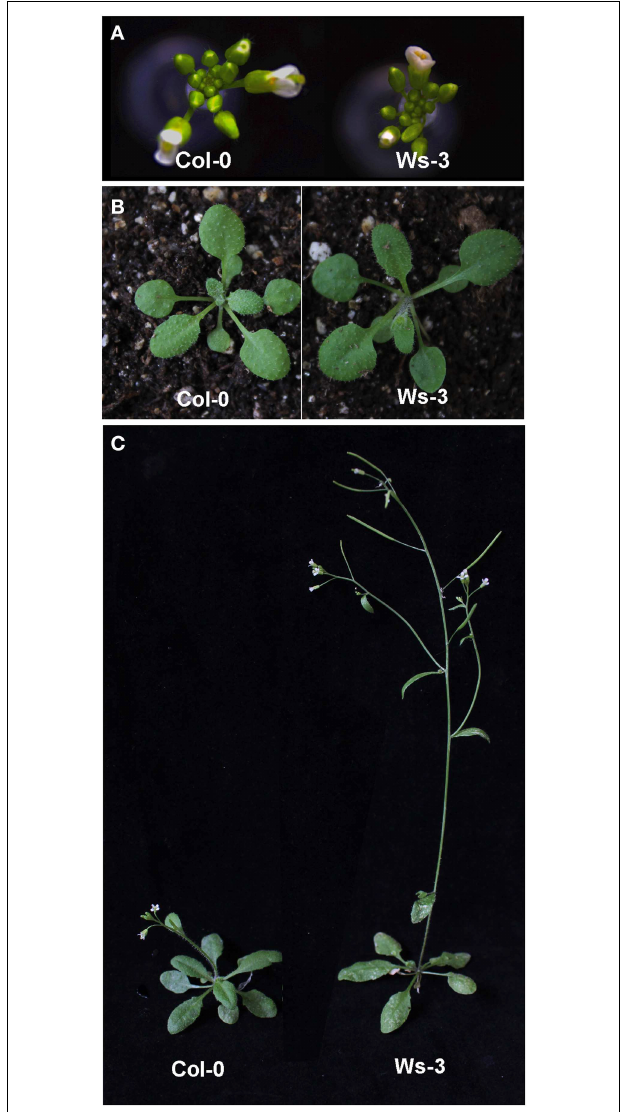
FIGURE 1 | Phenotypes of the Arabidopsis thaliana accessions used. (A) View of the inflorescence of Columbia (Col-0) and Wassilewskija (Ws-3). (B) View of the rosette before flowering of Columbia (Col-0) and Wassilewskija (Ws-3). (C) General architecture of Columbia (Col-0) and Wassilewskija (Ws-3) plants when flowering. In (A, C) , photographs were taken 3 weeks after sowing. Plants from the different accessions were cultivated at the same time under greenhouse